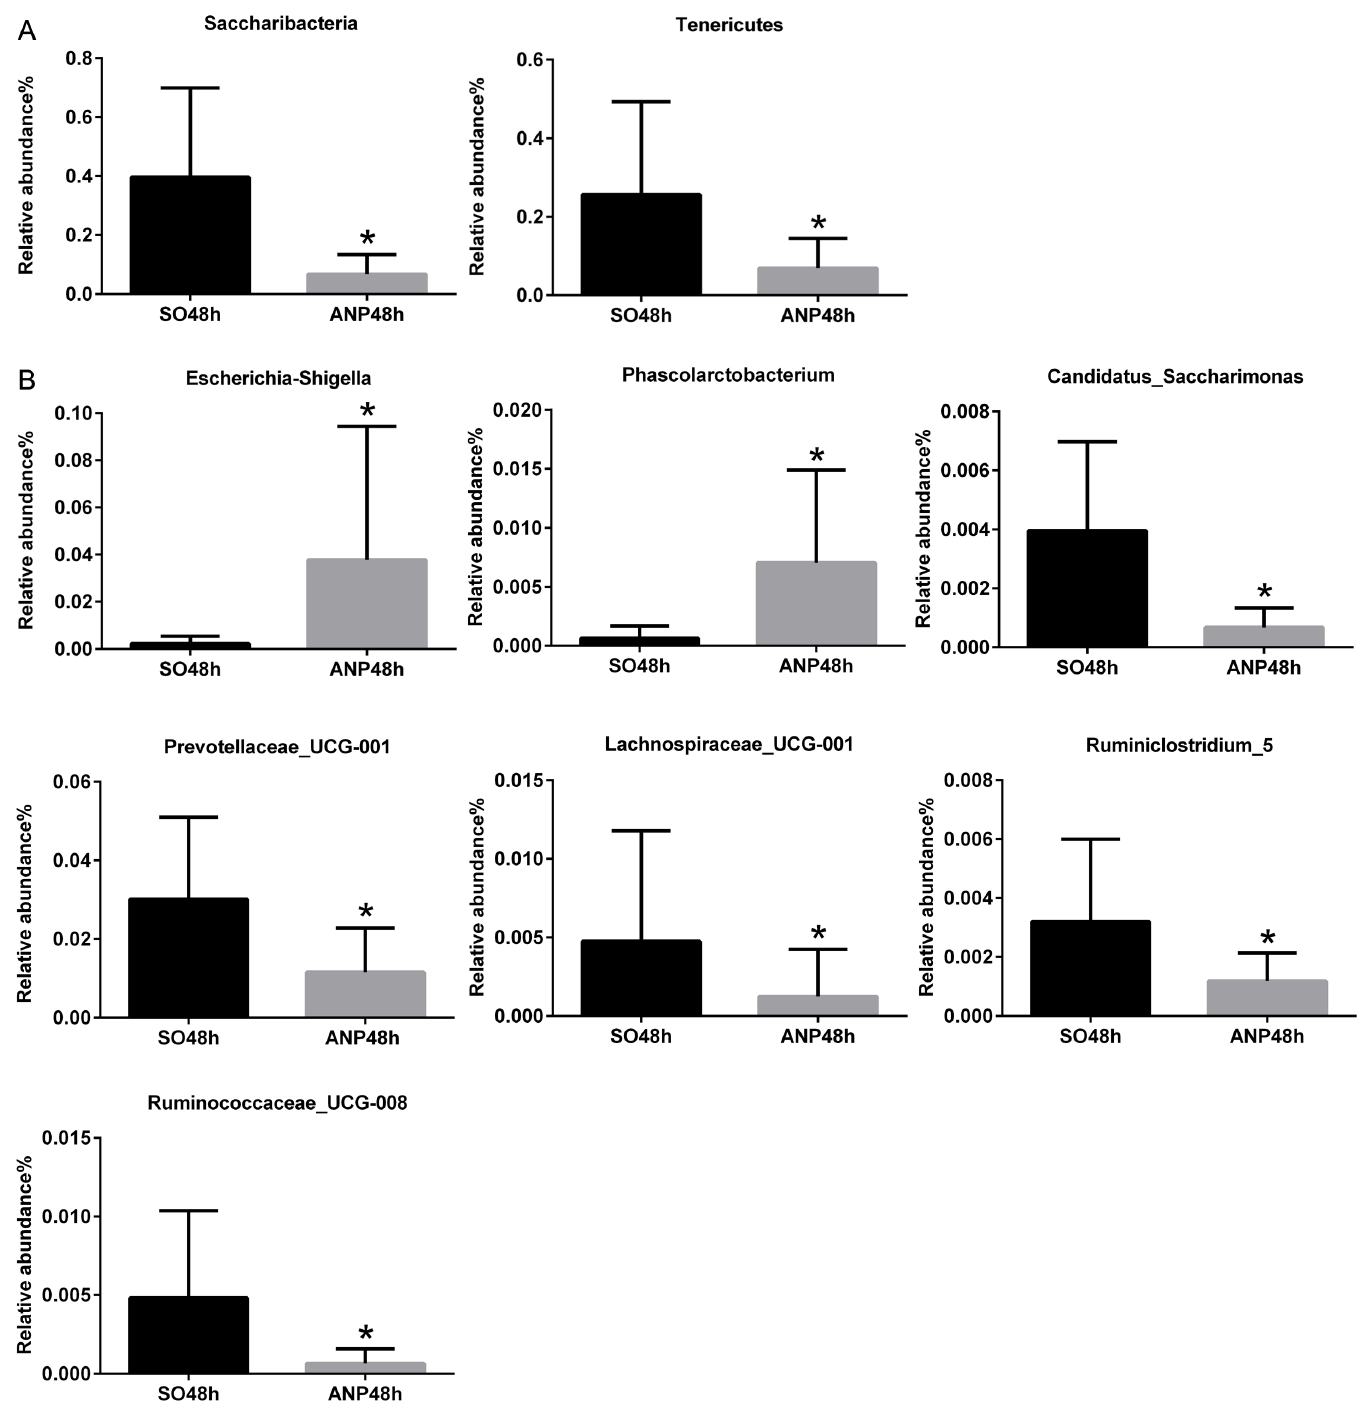
Fig 4. Relative abundance of significantly different phyla and genera betweenthe SO48h and ANP48h groups. (A) The significantly different phyla betweenthe two groups. (B) The significantly different generabetweenthe two groups. * p < 0.05